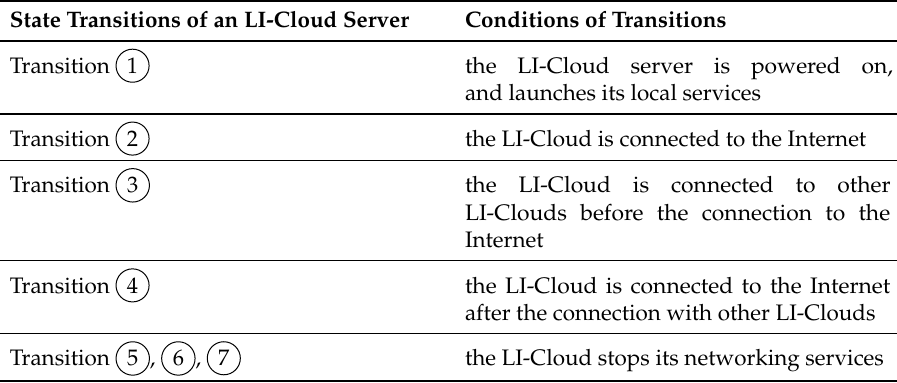
Table 4. State transition conditions of an LI-Cloud